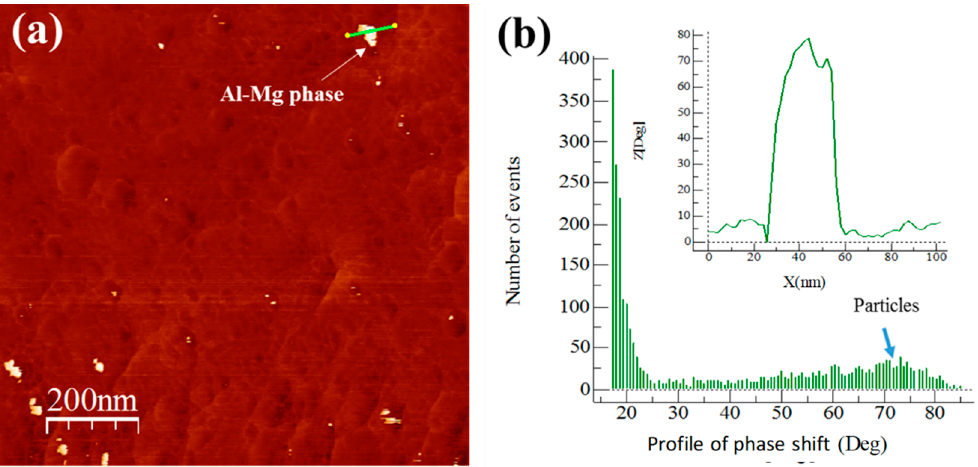
Figure 9. Al / Ref sample: ( a ) AFM tapping mode image and ( b ) degree distribution profile of the phase shift and distribution profile of a corresponding continuous line that crosses the bright area in the phase image (shown inset of the figure).